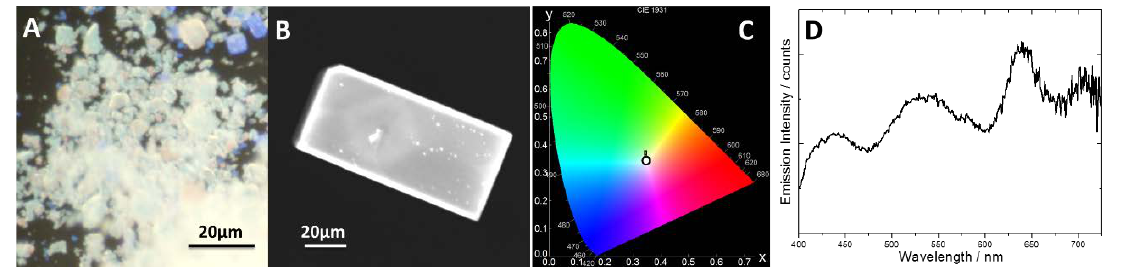
Figure 5. Fluorescence images of ( A ) powder and ( B ) single crystal MOF immersed in toluene/anisole/iodobenzene mixture in 7:4:2 proportion under UV excitation light (325–375 nm band pass filter). ( C ) CIE diagram for the single crystal shown in ( B , D ). Emission spectrum recorded under